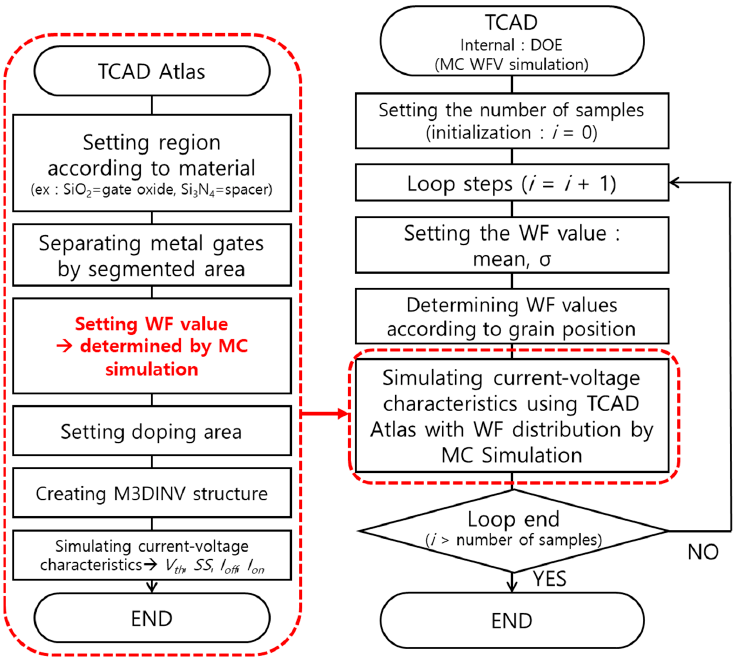
Figure 3. WFV simulation flowchart using technology computer-aided design (TCAD).